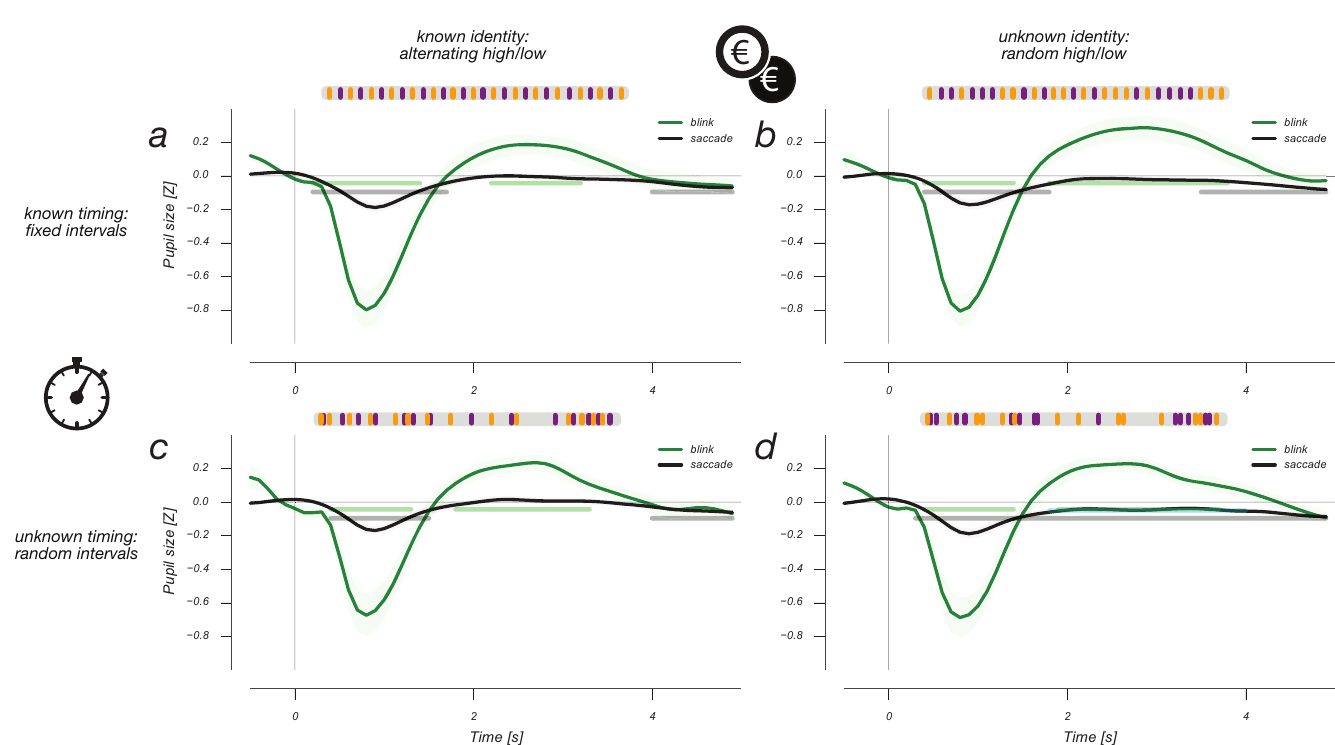
Fig 3. Finite impulse response curves triggered by ocular events. Both blinks and saccades cause an initial negative pupil response, presumably due to the transient increase in retinal illumination after each of these events. The blink response also shows a slower, but positive response. Neither of these two response profiles show any difference between experimental